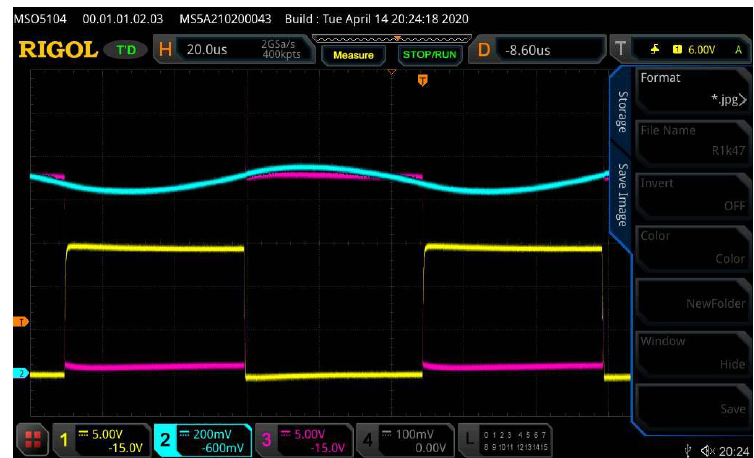
Figure 7. Measured waveforms of v GE (t) voltage, v CE (t) voltages and i L (t) current in the tested boost converter operating at load resistance R 0 = 47 Ω